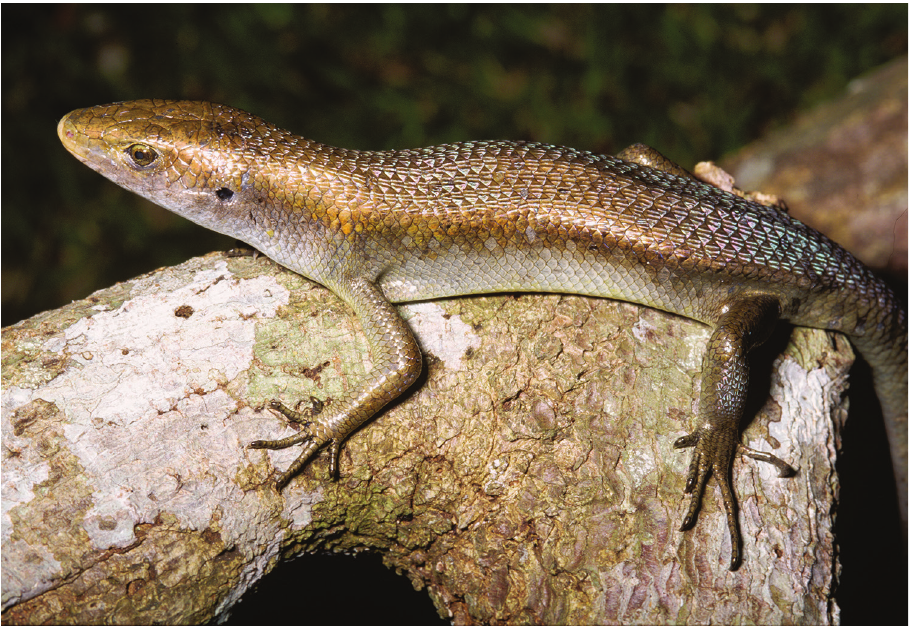
Figure 54. Eutropis multifasciata male (KU 334403) from Mt. Hilong-hilong in the Municipality of Remedios T. Romualdez, Agusan del Norte Province. Photo: RMB.